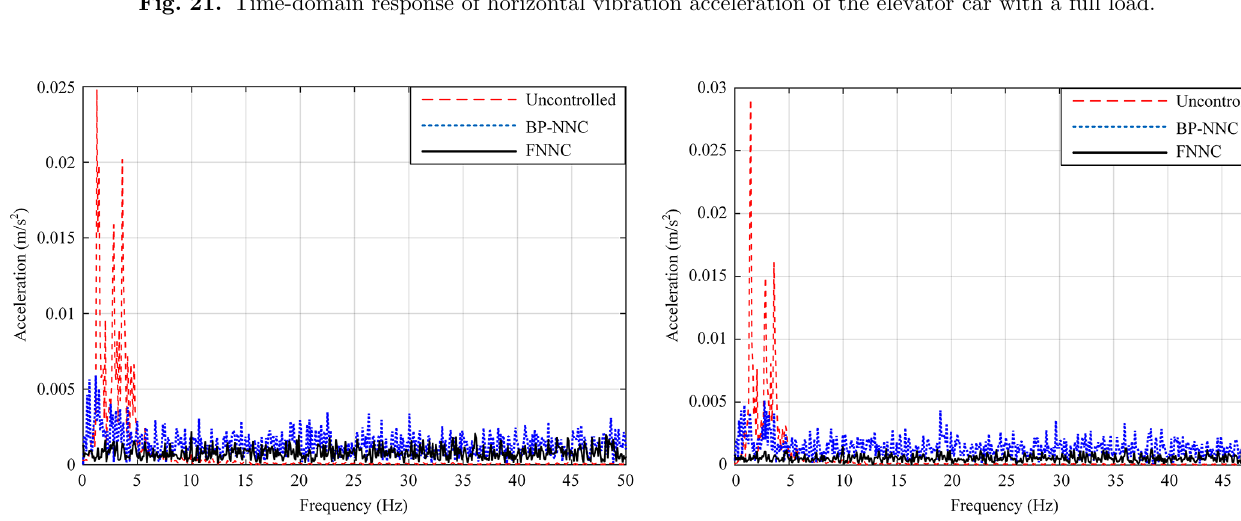
Fig. 24. Frequency-domain response of horizontal vibration acceleration of the elevator car with a full